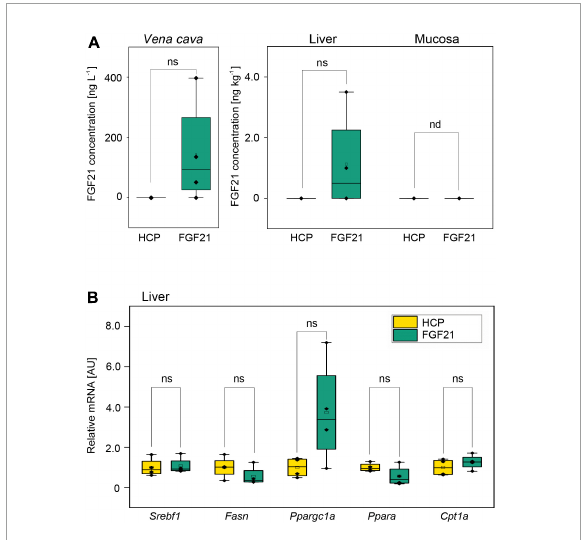
FIGURE4 The mean bioavailability and bioactivity of the purified fusion protein nTf338-FGF21-PLUS in an in vivo animal bolus feeding trial. FGF21 - / - knockout mice were starved for 16 h and gavaged with a 0.5 mL bolus of partially purified nTf338-FGF21-PLUS dissolved in water to a concentration of 50 µ g L - 1 FGF21 and 44 g L - 1 HCP (FGF21 group) or HCP only (HCP group). After 4 h, mice were sacrificed. (A) FGF21 concentration in the Vena cava , liver and mucosa of via FGF21-ELISA. (B) mRNA expression levels of the gene Srebf1 , Fasn , Ppargc1a , Ppara , and Cpt1a , determined in liver tissue via qPCR (primer are listed in Supplementary Table 1 ). Numbers represent mean ± SD. Significance was calculated by pair-sample t -test with * p <